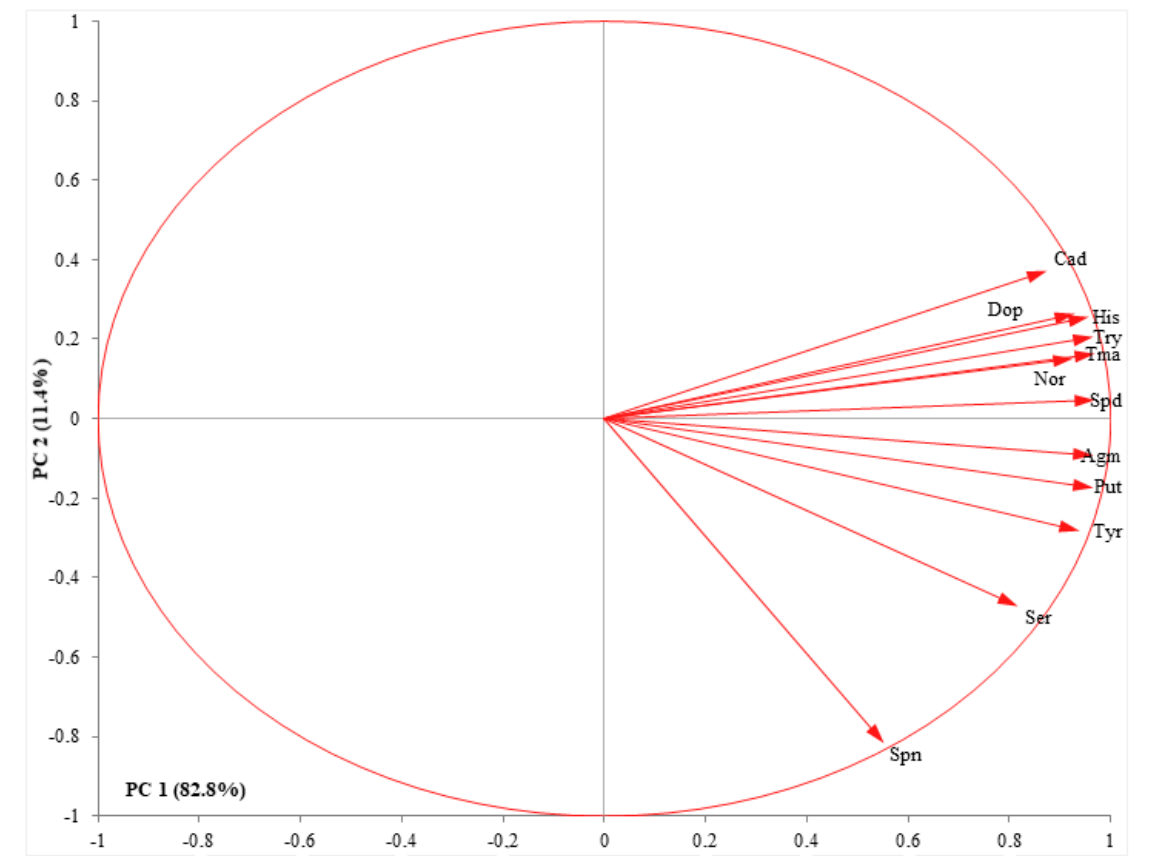
Figure 3. P.C.A. biplot (score and loadings plots) of berries colored by varieties. All biogenic amines are displayed. The size of the arrows indicates the contribution strength of the compound. Each point is the average of quaternaryplicate of each organic